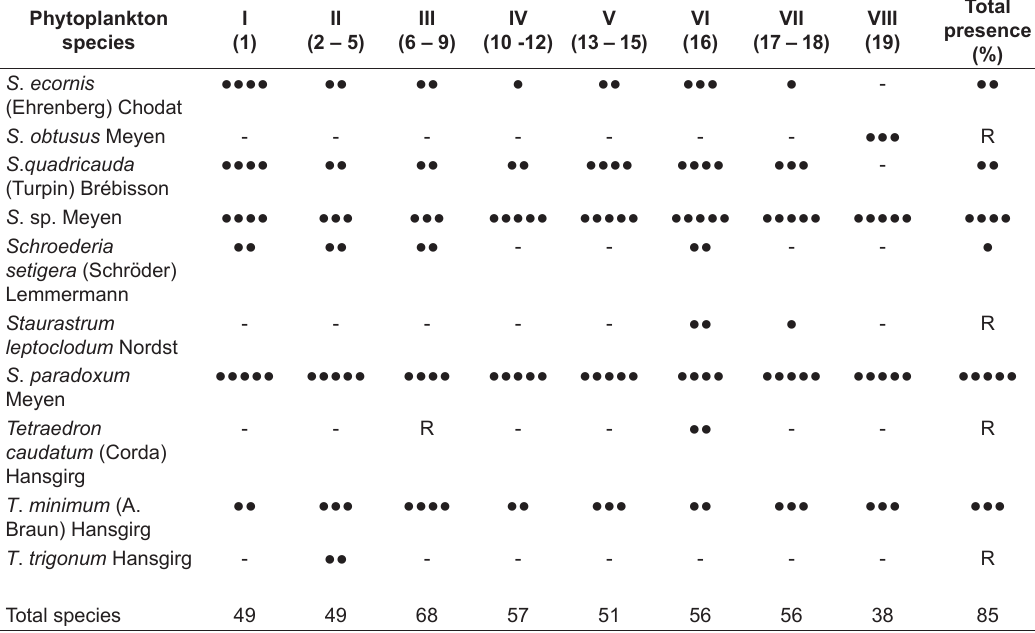
and Aulacoseira granulate ; besides Melosira varians was subdominant. In the Decorana analysis, the phytoplankton clusters showed a remarkable spread along axis 1 of the ordination diagram (Figure 7). The vast majority of the clusters that correspond to winter - spring assemblages occupied the left side of the diagram and those related to summer – autumn assemblages occupied the right side. DCA axis 1 scores showed a negative correlation with pH value ( r = -0.593, p = 0.033) and a positive correlation with SO4 2– ( r = 0.586, p = 0.035). DCA axis 2 scores correlated positively with water temperature ( r = 0.604, p = 0.029) and negatively with Mg 2+ ( r = -0.61, p = 0.014). 3.3. Zooplankton High levels of the Nile zooplankton standing crop were recorded at the sampling sites that located upstream of the wastewater discharge points with mean values varied between 26092 and 33849 ind. m –3 (Figure 3). In contrary, relatively lower values (19557 - 24180 ind. m –3 ) were recorded in the downstream sites. The highest zooplankton population density (avg. 29015 ind. m –3 ) in the southern sites at Aswan was followed by slight gradual decrease towards the north sites. Zooplankton population density sustained